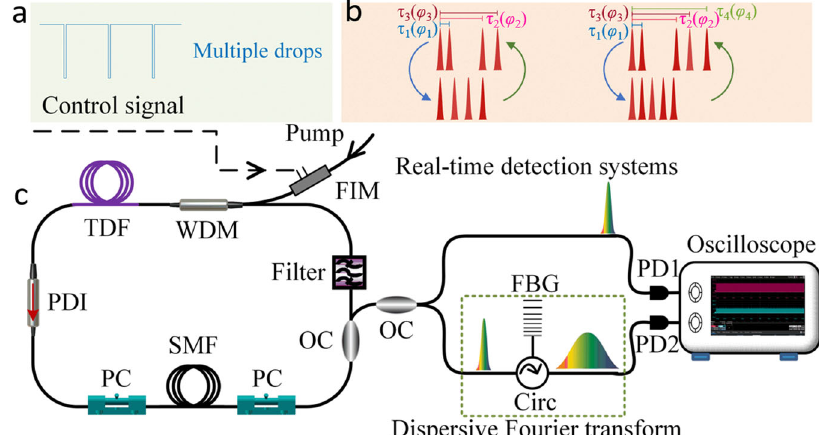
Fig. 1 Experimental setup of soliton molecular complexes. a External electronic modulation is implemented using a fi ber-coupled intensity modulator (FIM) in the pump beam. Control patterns are generated from arbitrary electronic waveforms driving the FIM. b Schematic representation of the recon fi gurable switching and internal degrees of freedom of the soliton molecular complexes containing four or fi ve solitons. c Schematic of the fi ber laser and real-time detection system. WDM wavelength division multiplexer, PC polarization controller, PDI polarization-dependent isolator, SMF single-mode fi ber, TDF thulium-doped fi ber, OC optical coupler, FBG fi ber Bragg grating, Circ circulator, PD